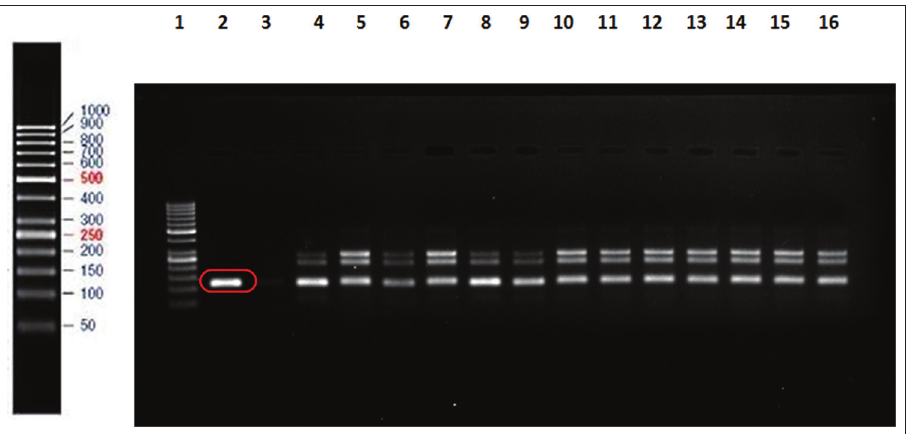
Figure-4: Fecal samples positive for ISMAP 02 nested product (117bp). Lane 1 consists of 50 bp DNA marker, lane 2 is positive standard genomic DNA, lane 3 is negative control, and lanes 4-16 consist of positive fecal samples for ISMap 02 nested polymerase chain